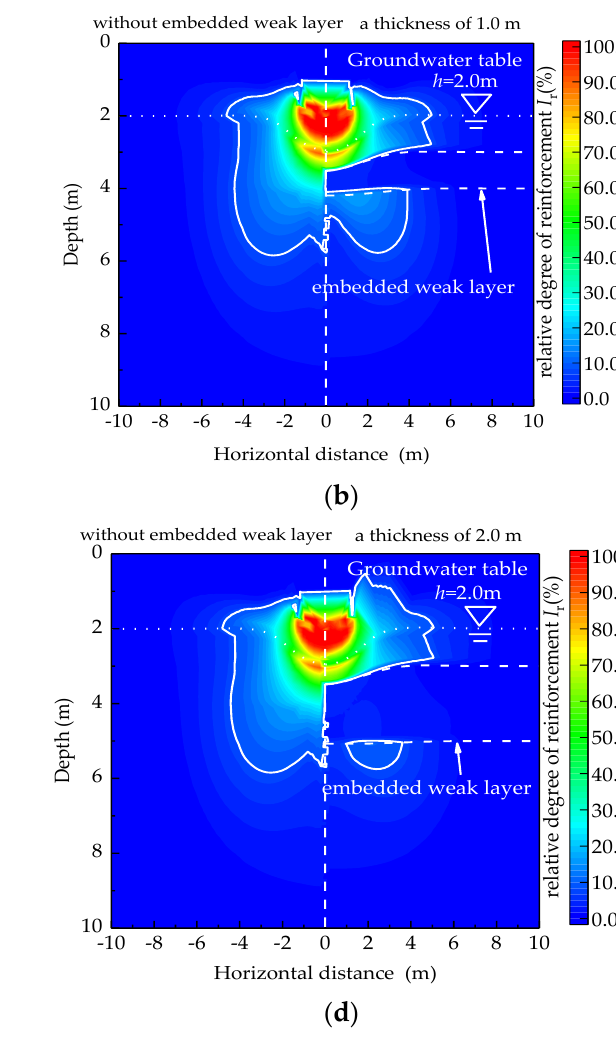
Figure 10. Distributions of I r in grounds with different thickness of embedded weak layer. ( a ) 0.4 m;